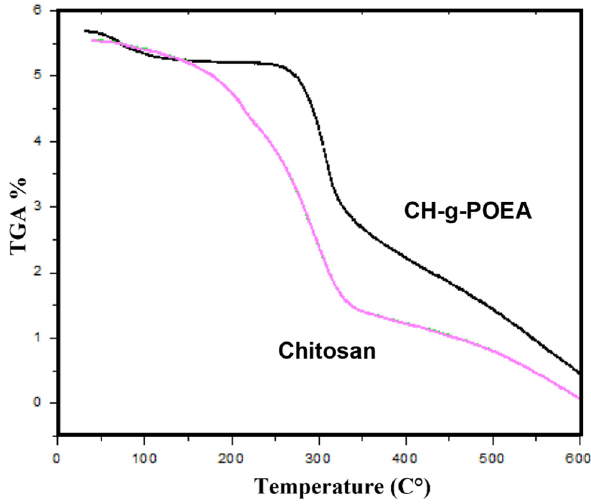
Figure 3: TGA of CH - g - POEA and chitosan.